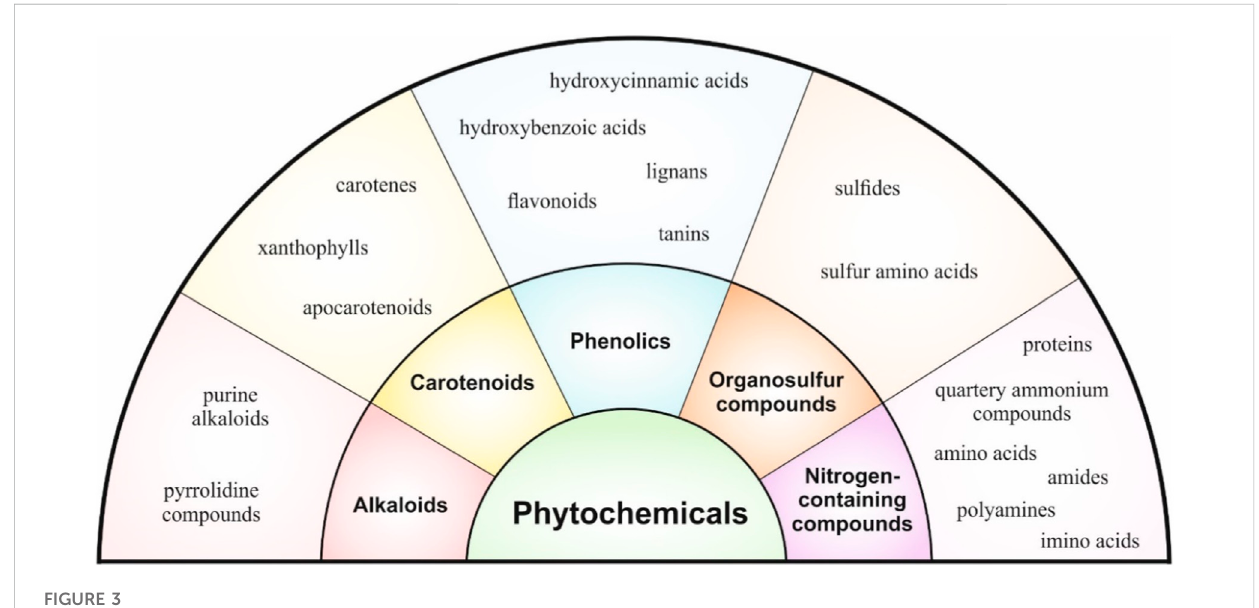
Classi fi cation of